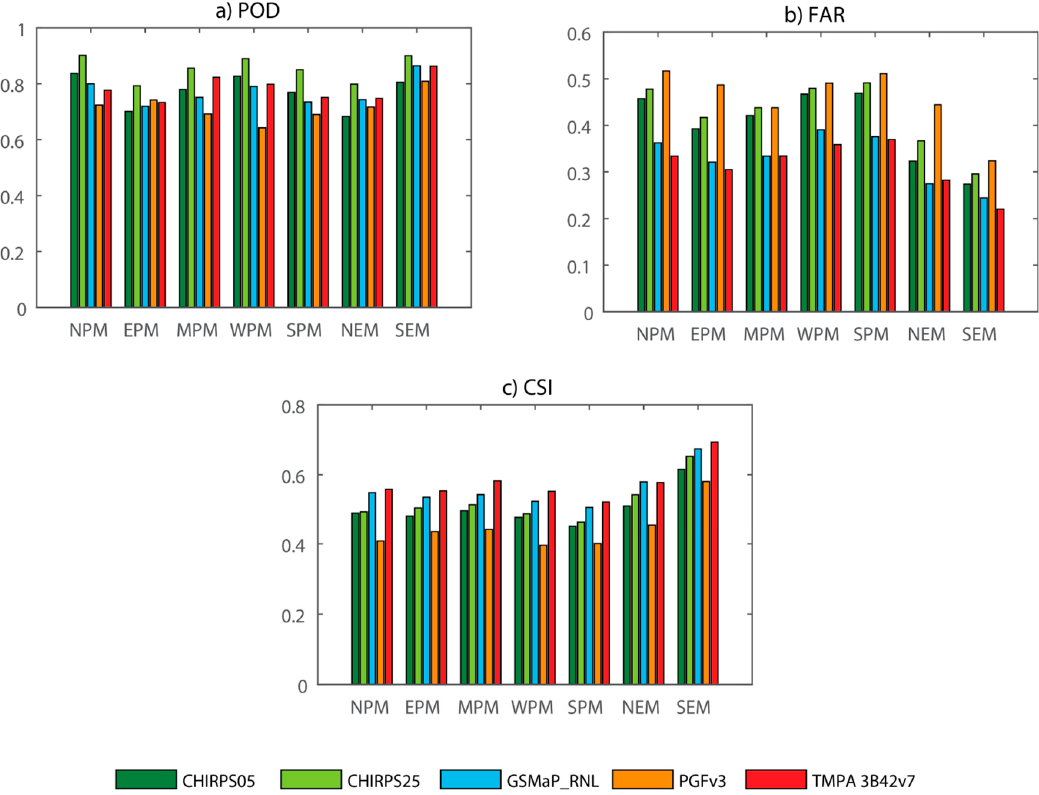
Figure 6. The overall performance scores of gridded precipitation products according to sub-regions based on daily data: ( a ) POD, ( b ) FAR, ( c ) CSI. Remote Sens. 2020 , 12 , 613